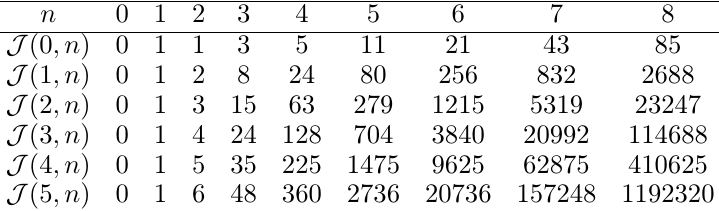
Table 3. The terms of {J ( s, n ) } for 0 ≤ s ≤ 5 and n ≤